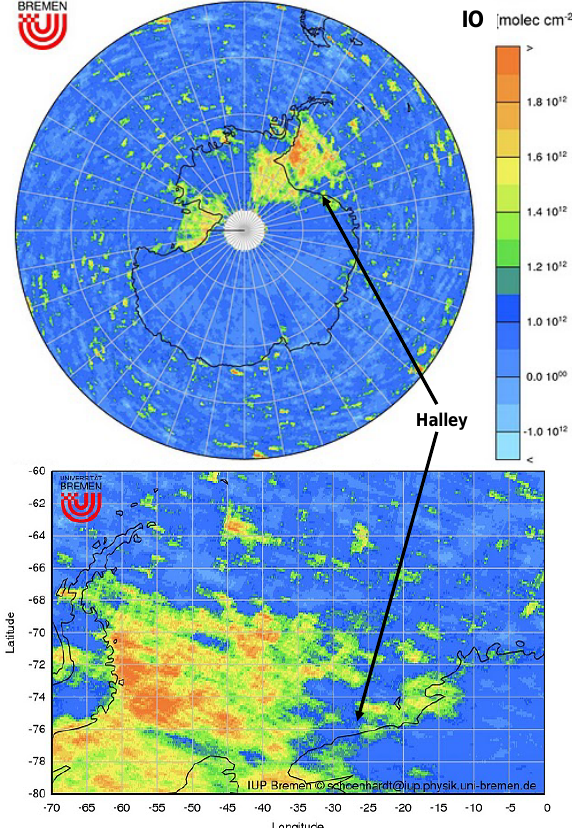
Fig. 5. Average IO vertical column densities over Antarctica measured by satellite from 25 January to 7 March 2009. The highest amounts of IO are observed over the ice covered Weddell Sea.